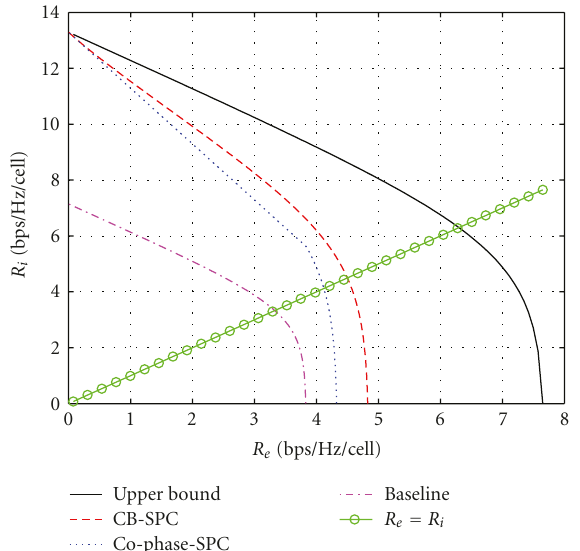
Figure 13: Double-class network, α = 1, β = 2, and SNR = 20dB.